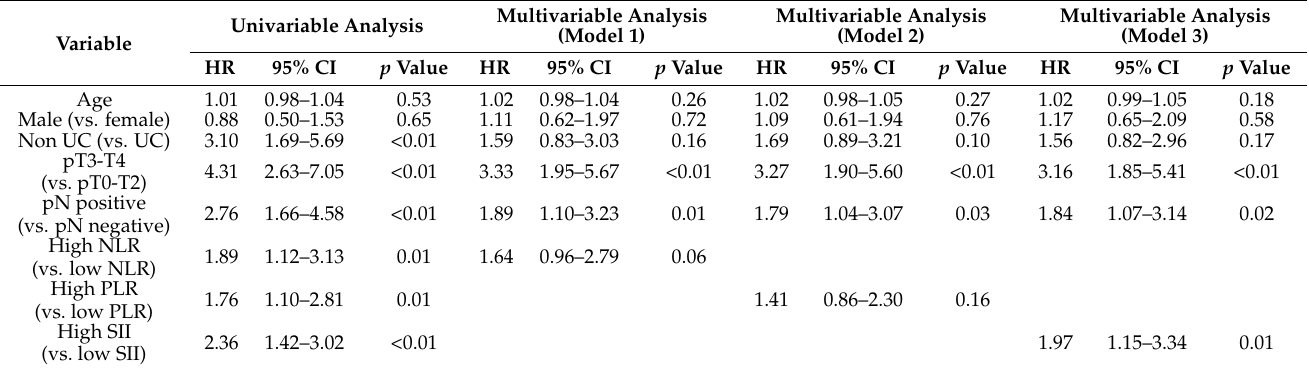
Table 3. Univariable and multivariable analyses of associations between various parameters and cancer-specific survival. Variable